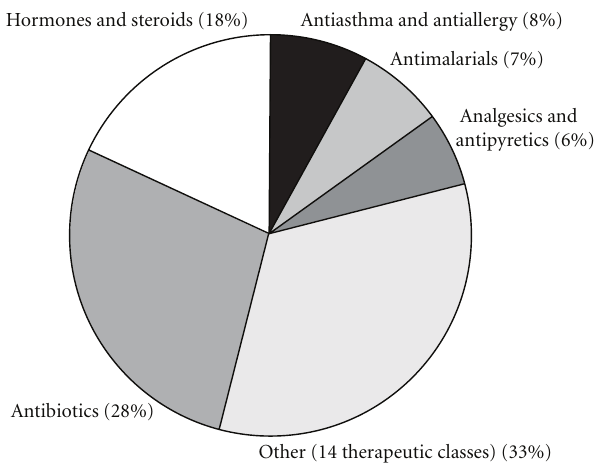
Figure 1: Reports of counterfeit drugs by therapeutic class received by WHO between 1999 and 2002, adapted from International policy network repost [4]. Prevalence of fake medicines is seen across all classes of drugs, a large proportion of them being